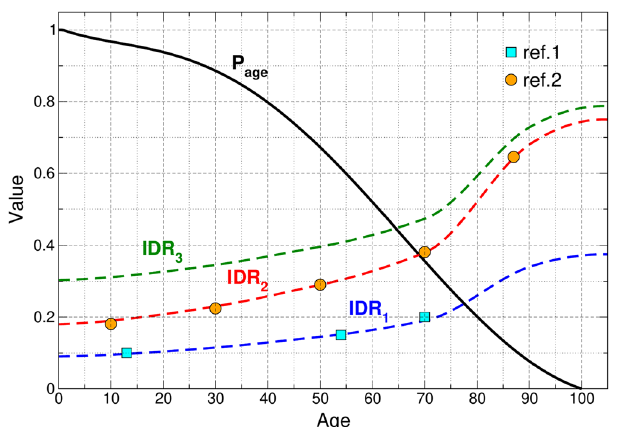
Figure 1. Age distribution function P age and IDR as a function of age for the three scenarios considered in this work: one in which half of symptomatic cases are detected (IDR 1 ), one in which all of them are (IDR 2 ), and one in which all the symptomatic and 15% of the asymptomatic/oligosymptomatic cases (for each age) are detected (IDR 3 ). Ref. 1: 13 and Ref. 2: 20